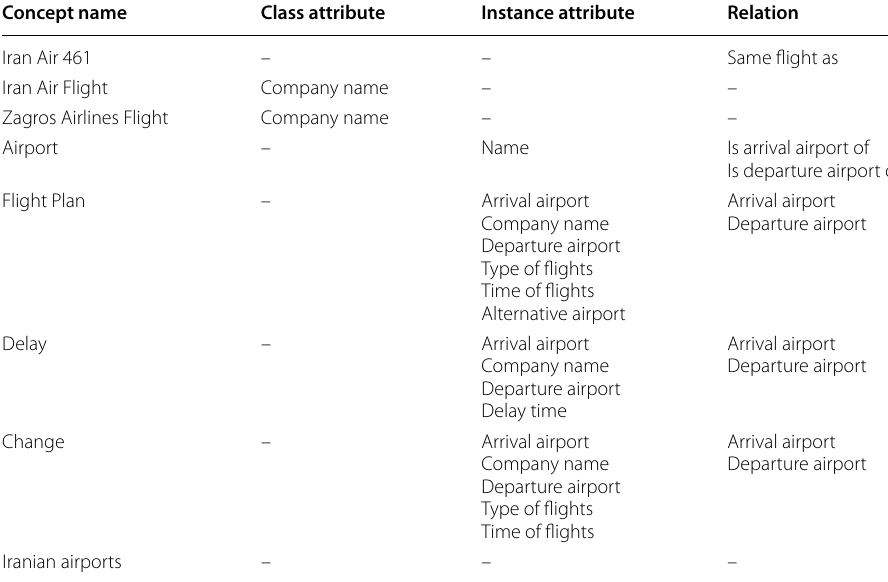
Table 3 Dictionary of concepts, examples, relationships, and features Concept name